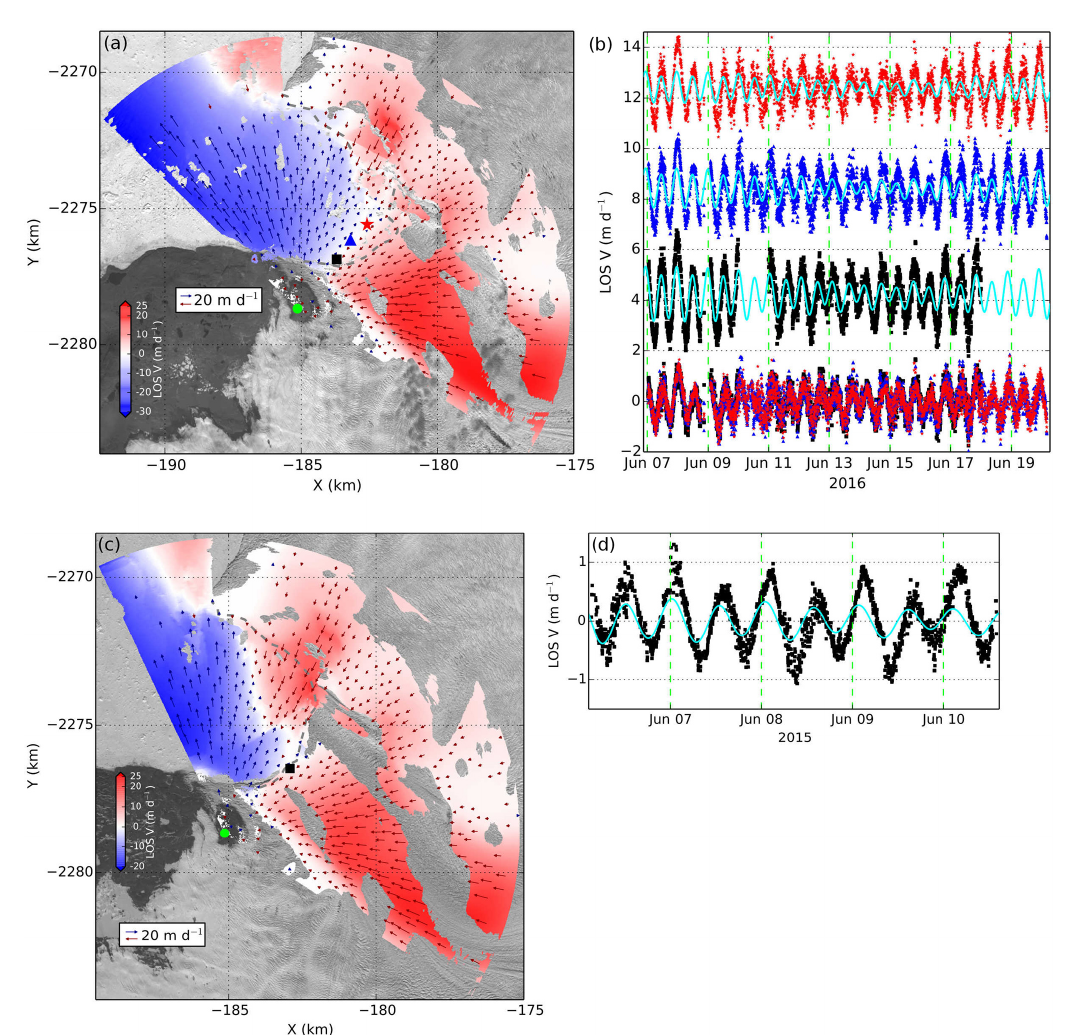
Figure 8. (a, b) TRI observed ice motion that is non-parallel to long-term ice flow motion in the mélange of 2016. In (a) , color map shows LOS velocity by interferometry, from a 1-day median average. Arrows show velocity estimates from feature tracking projected onto the LOS direction (dark red when ice moves towards the radar and dark blue when ice moves away). Dashed grey line shows glacier front location from TRI image. Black square, blue triangle, and red star mark three points where 2-D velocity direction is nearly perpendicular to radar LOS. Their LOS velocity time series are shown in (b) . Note that the point with blue triangle marker corresponds to the marked point in Fig. 3a. Top three rows in (b) show TRI-observed LOS velocities for selected points; cyan curves are predicted LOS velocities based on the imaging geometry, assuming ice is free-floating. LOS velocities are offset for clarity. Bottom row shows residual time series by subtracting the cyan curves. (c, d) TRI observed ice motion that is non-parallel to long-term ice flow motion on the glacier front for 2015. Colors and arrows in (c) represent the same parameters as in (a) . A point immediately adjacent to the glacier front was chosen, marked by black square, with its LOS velocity observed with TRI and predicted by tide variations shown in (d) . Cyan curve in (d) shows predicted LOS